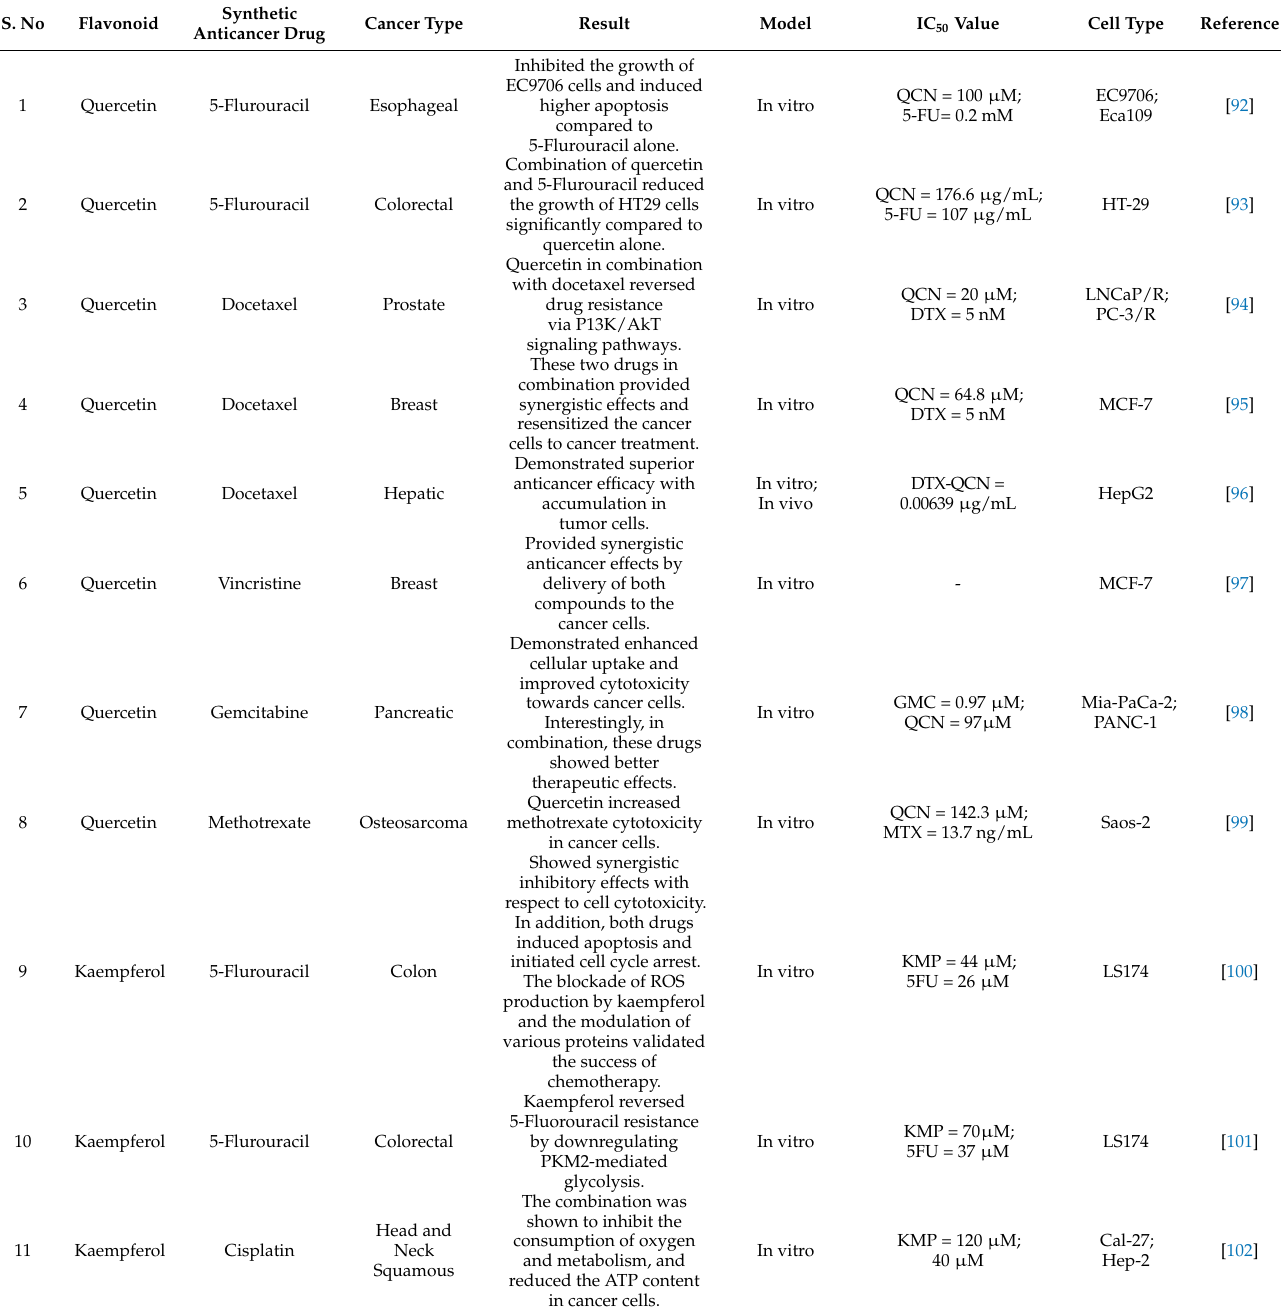
Table 1. Various reported combined systems incorporating flavonoid and synthetic anticancer agents. The literature has reported several pieces of evidence; however, we have summarized only the more recent instances of combinations of flavonoids with synthetic anticancer